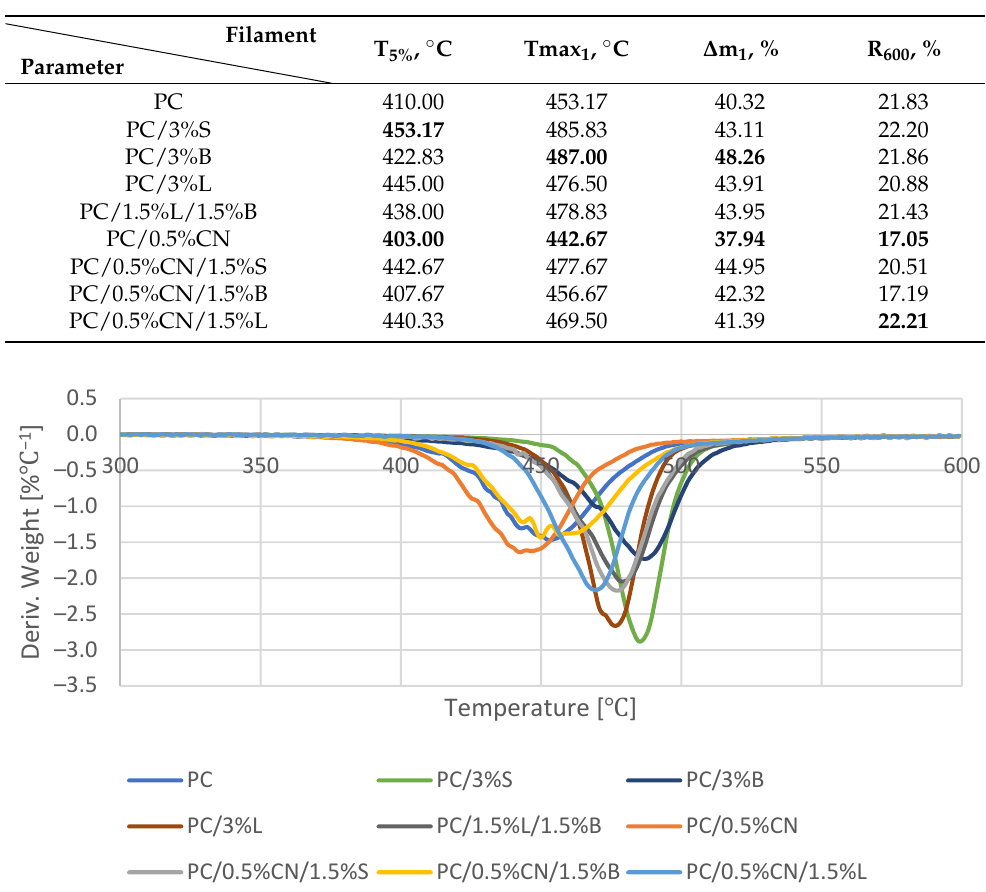
Table 5. The results of research on the properties of thermostability of composites.